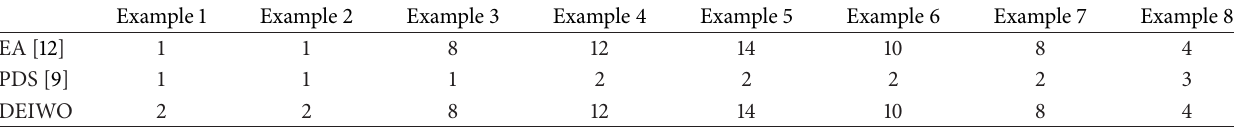
Table 13: Comparison of the number of function evaluations required by the DEIWO for all the examples.